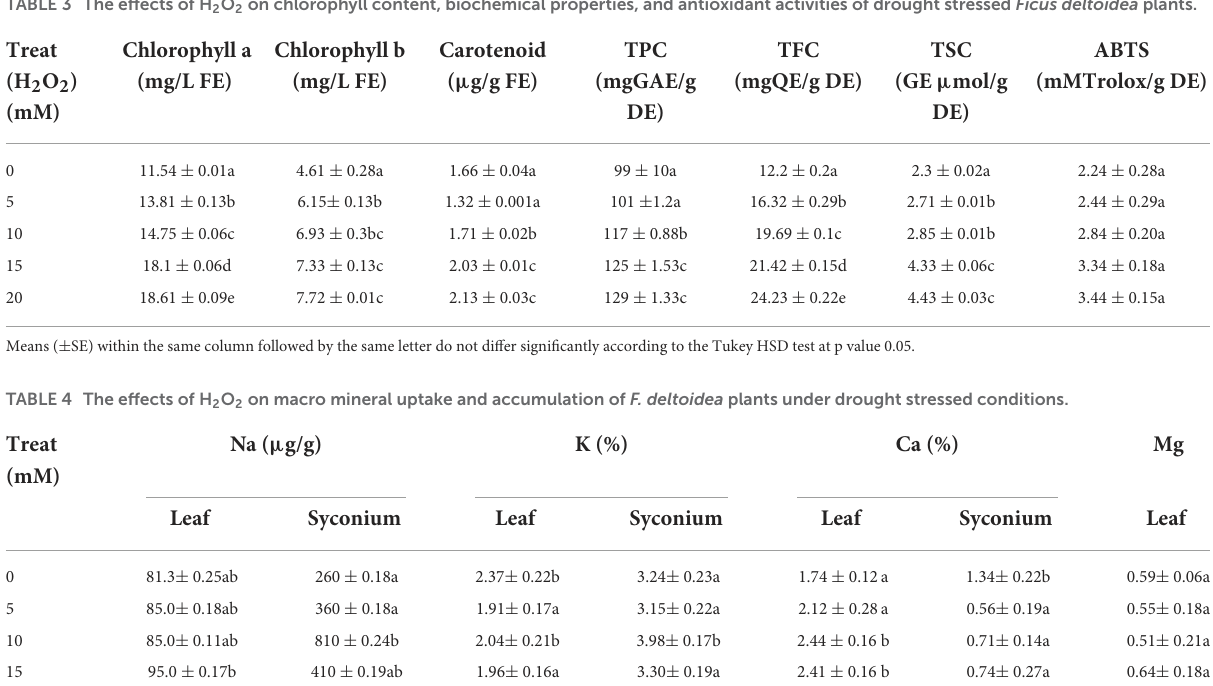
TABLE 3 The effects of H 2 O 2 on chlorophyll content, biochemical properties, and antioxidant activities of drought stressed Ficus deltoidea plants.